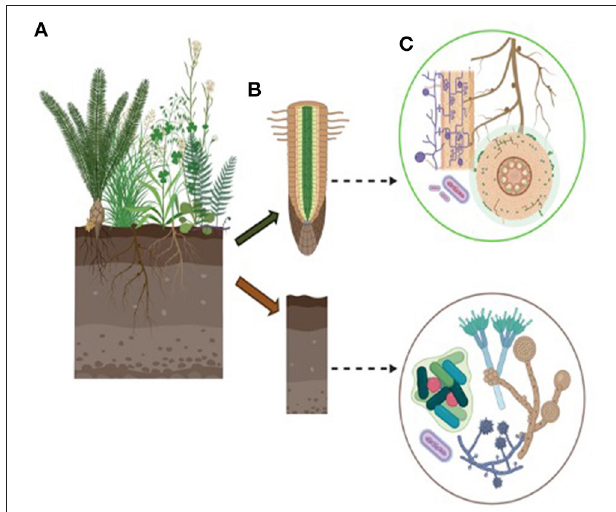
FIGURE 1 | Plants interact with a plethora of rhizosphere and endophytic microbes. These microbes, mainly bacteria and fungi, can positively affect plant development and performance, especially under abiotic and biotic stressful conditions. (A) Phytostimulation, which is the direct stimulation of the plant growth via the expression of phytohormones as seen with phytohormones as seen with several species from the Bacillus ( Singh et al., 2019) and Pseudomonas genus (Kumari et al., 2016). (B) Accession of essential nutrients by acting as biofertilizers, as seen with the nitrogen-fixing and phosphate-solubilizing bacteria or the mycorrhizal fungi, (C) Defense against herbivory and pathogens by acting as biological control agents, such as the fungi Trichoderma ( Elad, 2000), Penicillium (Rani et al., 2007), or the bacterial genus Bacillus (Pérez-García et al., 2011). In an attempt to harness these benefits, propagules are applied intentionally in the soil, roots, or